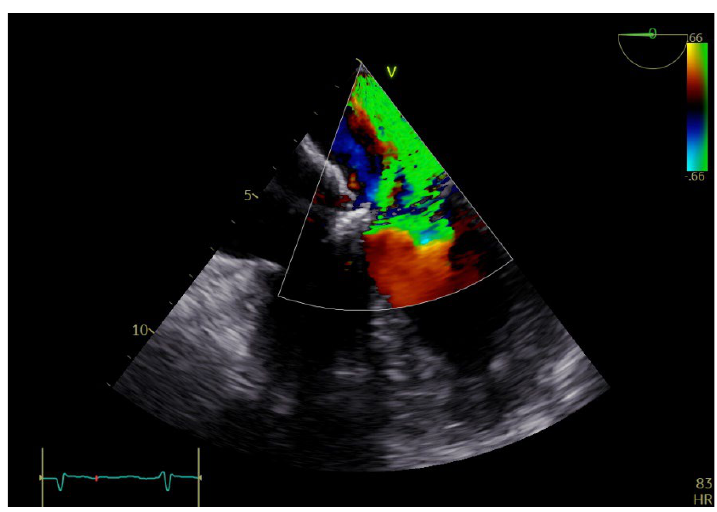
Figure 3. TEE: color Doppler revealing severe mitral regurgitation .